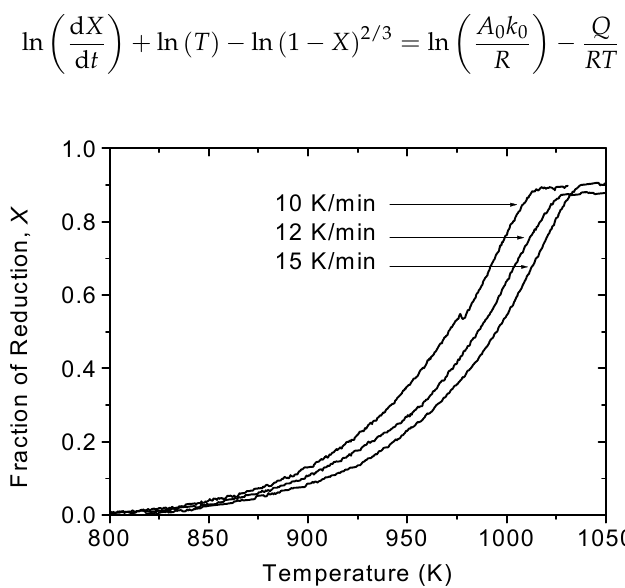
Figure 3. The non ‐ isothermal reduction curves of shallow powder bed of Fe 2 MoO 4 [2]. Figure 3. The non-isothermal reduction curves of shallow powder bed of Fe 2 MoO 4 In Equation (4), the terms on the left hand side can be evaluated based on the reaction rate, conversion degree and temperature obtained from the non ‐ isothermal curves in Figure 3. An Arrhenius plot, using Equation (4) for different heating rates, is presented in Figure 4. Figure 4. Arrhenius plot for the non ‐ isothermal reduction of shallow powder beds of Fe 2 MoO 4 [2]. The activation energy for Reaction (2) obtained from the regression line, in Figure 4, is 158.3 kJ/mol. Note that high correlation factor obtained suggests that the activation energy is independent of the heating rate, which in turn indicates that activation energy is a real function of the reacted fraction at a given temperature. The observed dependence implies that the Equation (4) provides accurate values of activation energies. In fact, the value of 158 kJ/mol is in good agreement with the value obtained from the isothermal experiments, 173 kJ/mol. 3.1.3. Characterization of Fe 2 Mo Intermetallic Figure 5 shows a Scanning electron microscope (SEM) image of reduced Fe 2 MoO 4 isothermally at 1173 K [2]. The sponge ‐ like structure is the result of the removal of oxygen which increases the specific surface area. The X ‐ ray diffraction spectrum of the same sample is given in Figure 6 [2]. Two